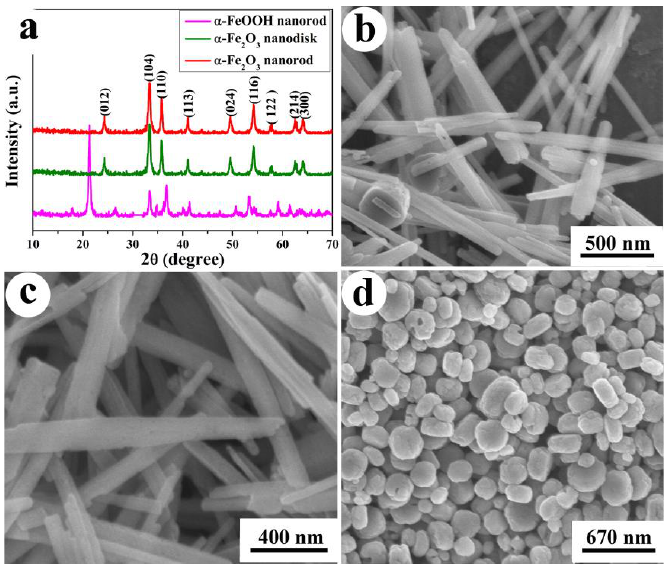
Figure 1. ( a ) XRD patterns of the different iron-based samples. SEM images of different iron-based samples of the α -FeOOH nanorod ( b ) , α -Fe 2 O 3 nanorod ( c ) and α -Fe 2 O 3 nanodisk ( d